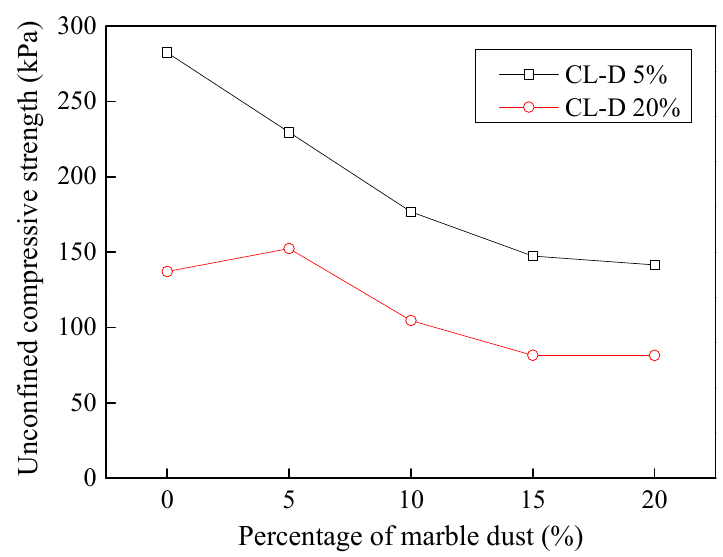
Figure 18. Improvement of dyeing effluent contaminated CL soil using marble dust.